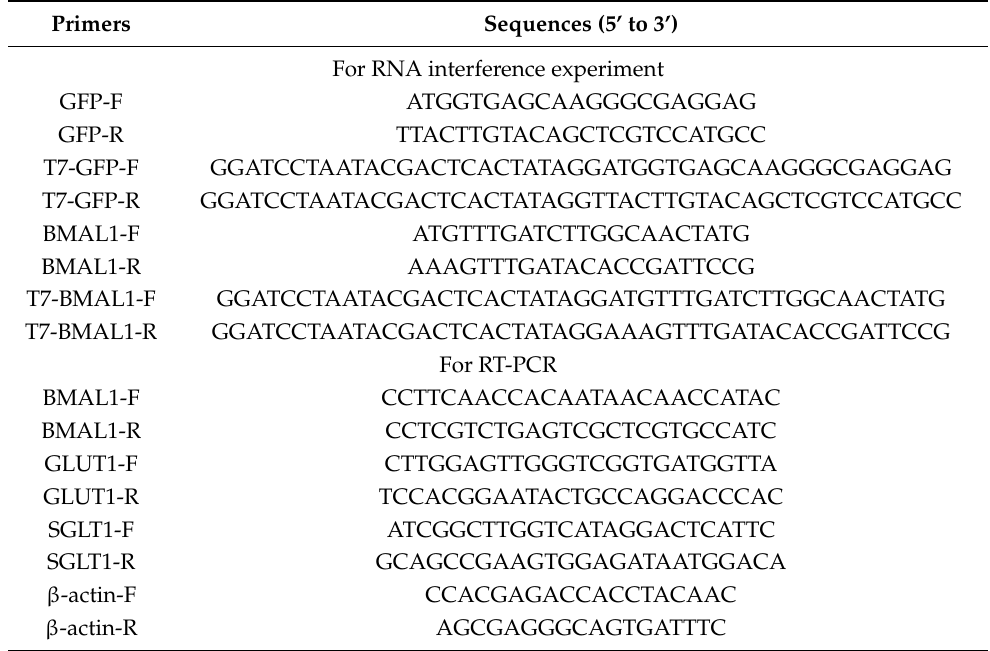
Table 1. Summary of primers used in this